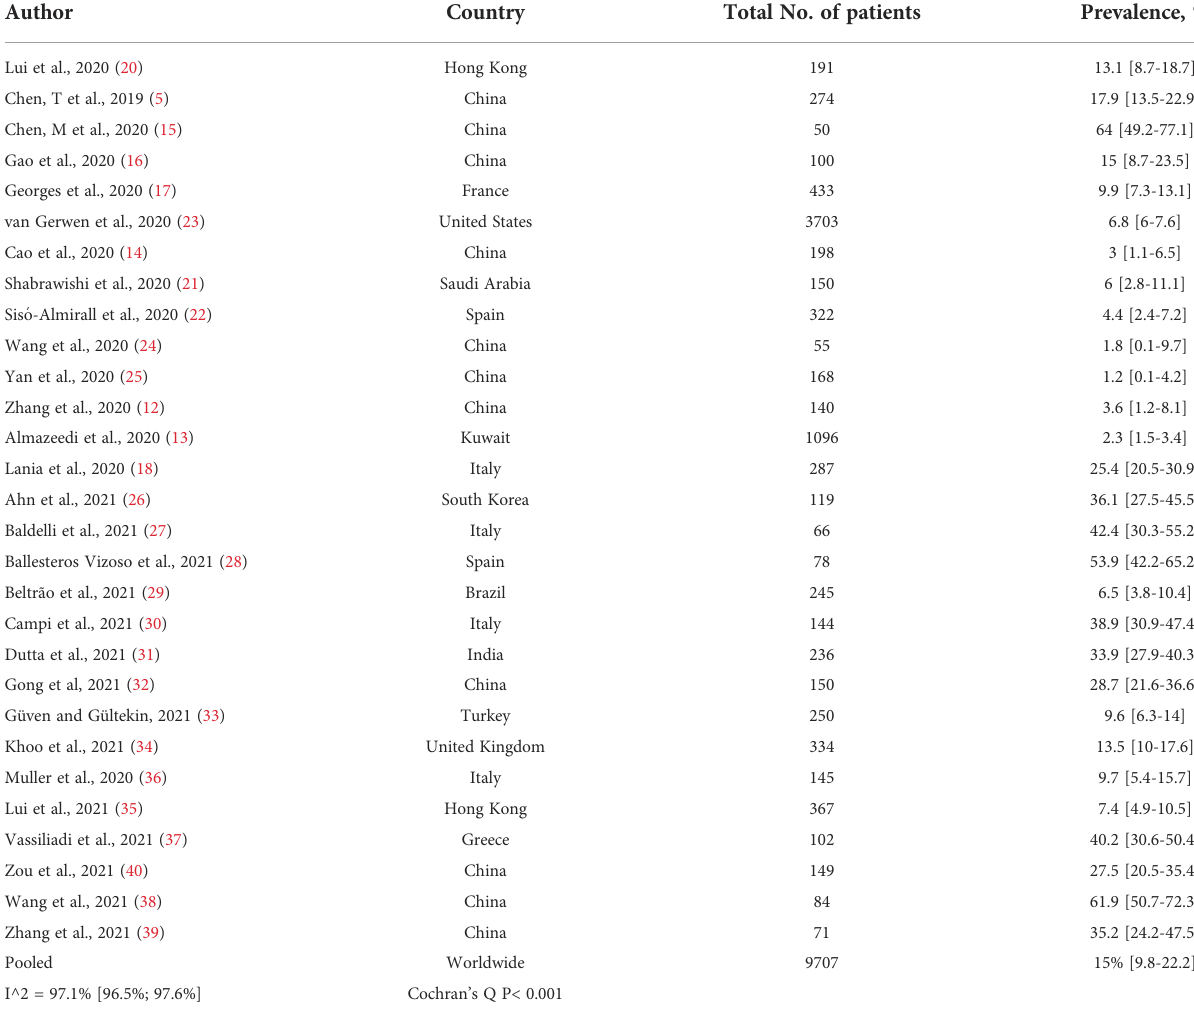
TABLE 2 Evaluation of the prevalence of thyroid dysfunction among COVID-19